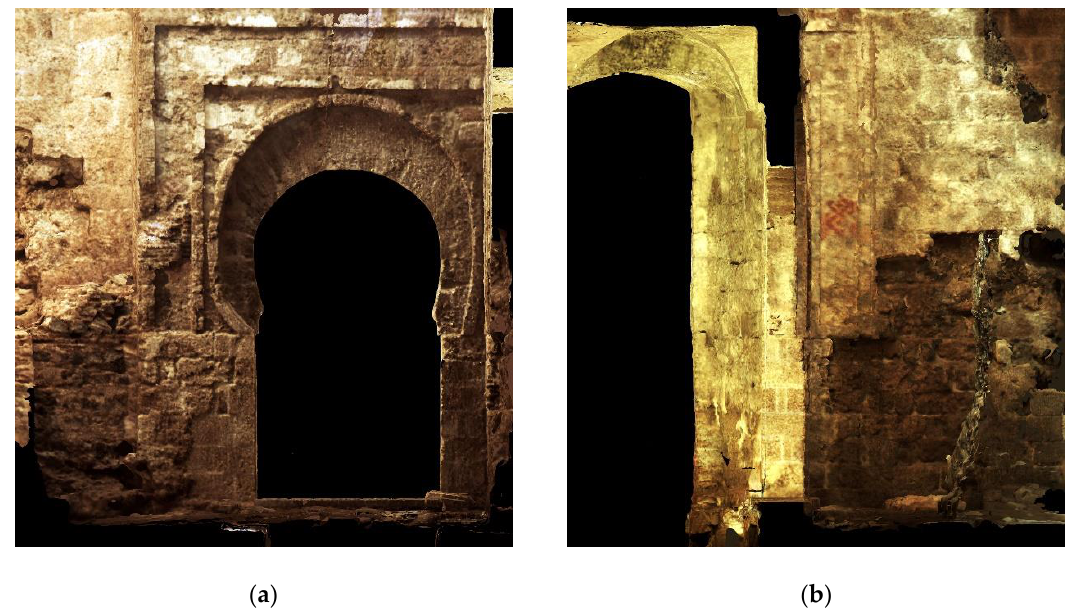
Figure 7. Orthoimages obtained from the meshed model. ( a ) Frontal view of the gate. ( b ) Adjacent wall with remains of medieval patterned paintings.